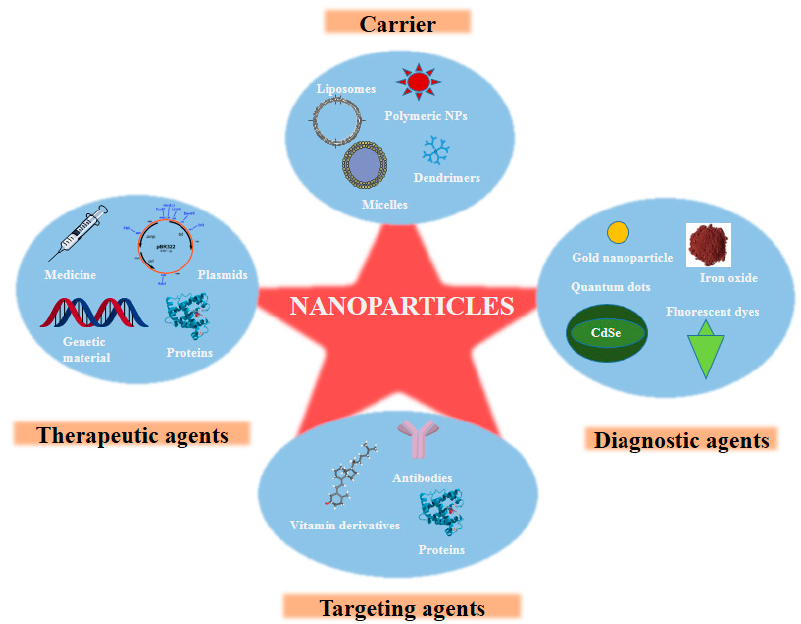
Figure 2. Nanoparticles in the management of stroke.